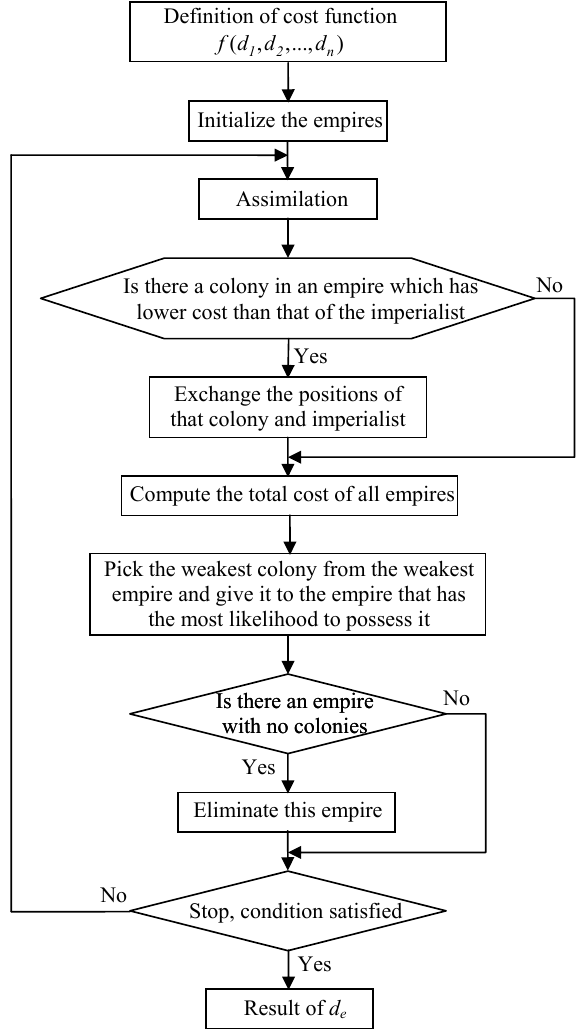
Fig. 2. Flowchart of the damage detection method using imperialist competitive